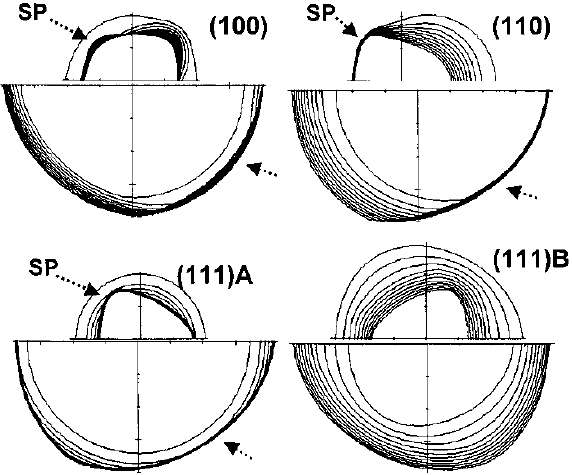
(v) The upper contours of membranes and mesa are not exclusively composed of linear segments in contrast with the behavior observed for such structures micromachined in silicon surfaces. In fact we are concerned either with rounded contours (laws 1 and 4) or with partly rounded contours (laws 2 and 3). So the anisotropy seems to be closer from an anisotropy of type 2 than from an anisotropy of type 1. We regret the absence of published images for structures micromachined in GaAs surfaces that does not allow